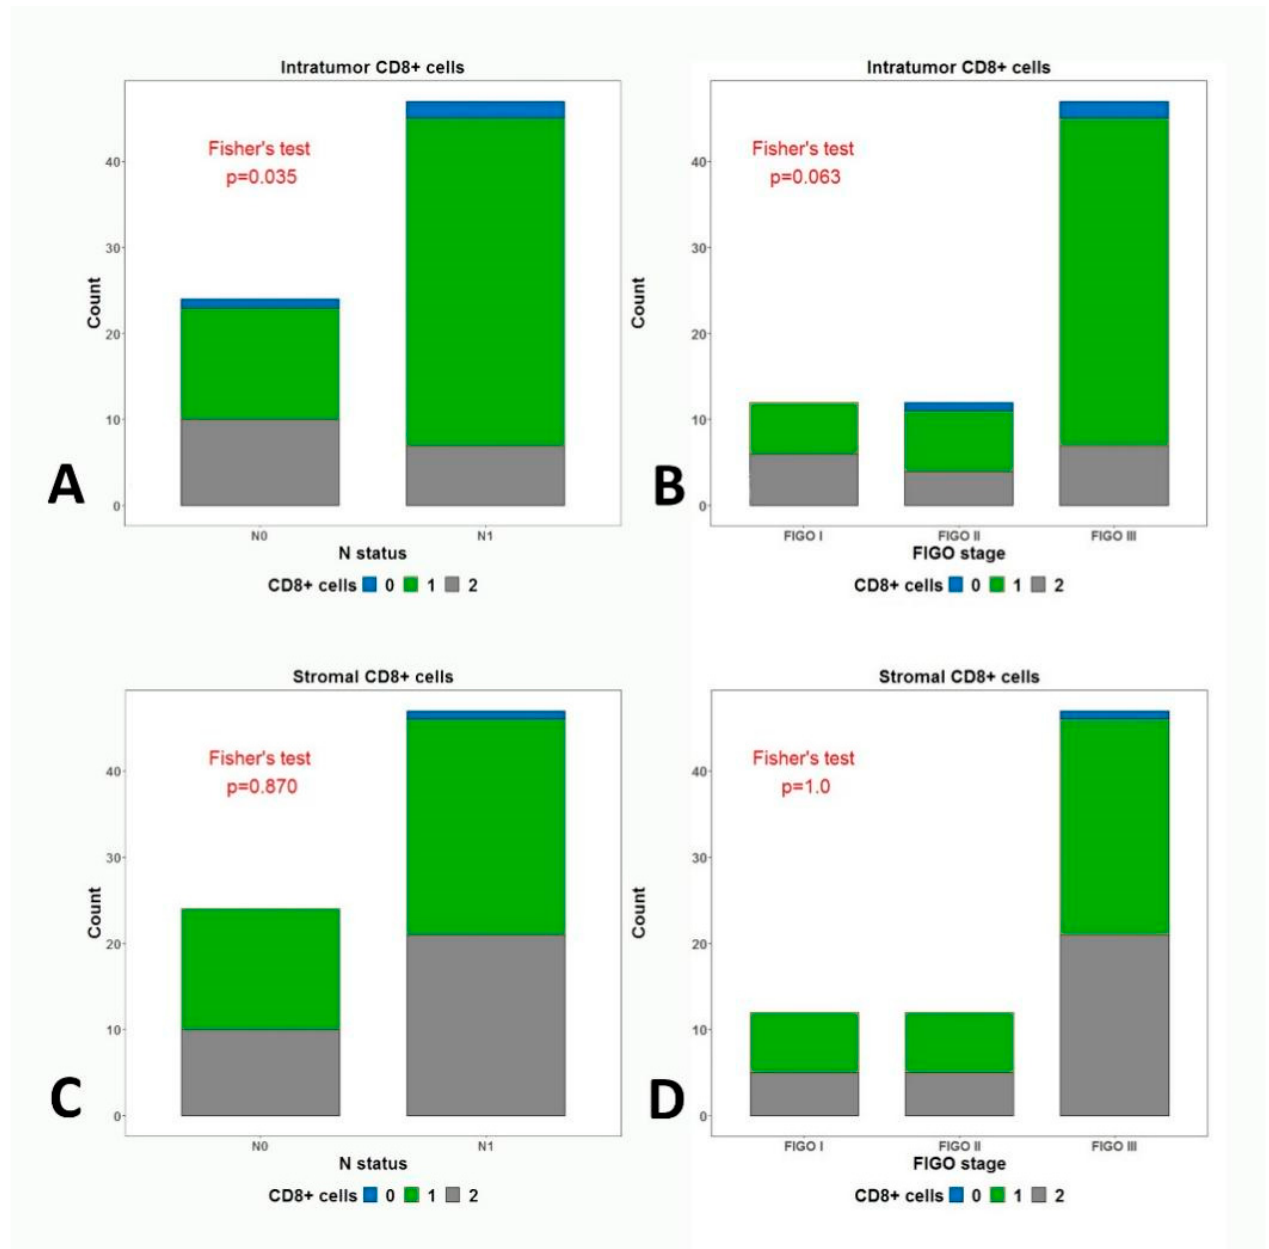
Figure 5. Fisher’s test for the association between ( A ) intratumor CD8 expression and N status; ( B ) intratumor CD8 expression and FIGO stage; ( C ) Stromal CD8 expression and N status; ( D ) stromal CD8 expression and FIGO stage.